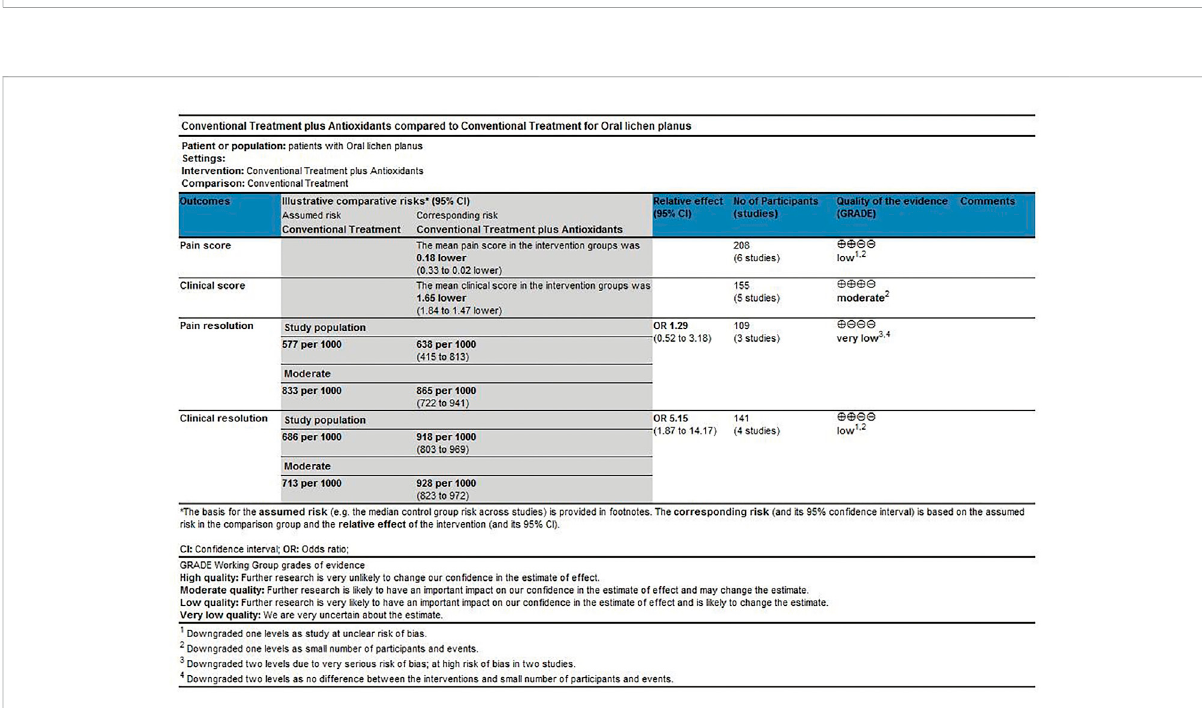
FIGURE 9 Conventional treatment plus antioxidants compared with conventional treatment for treating oral lichen planus.